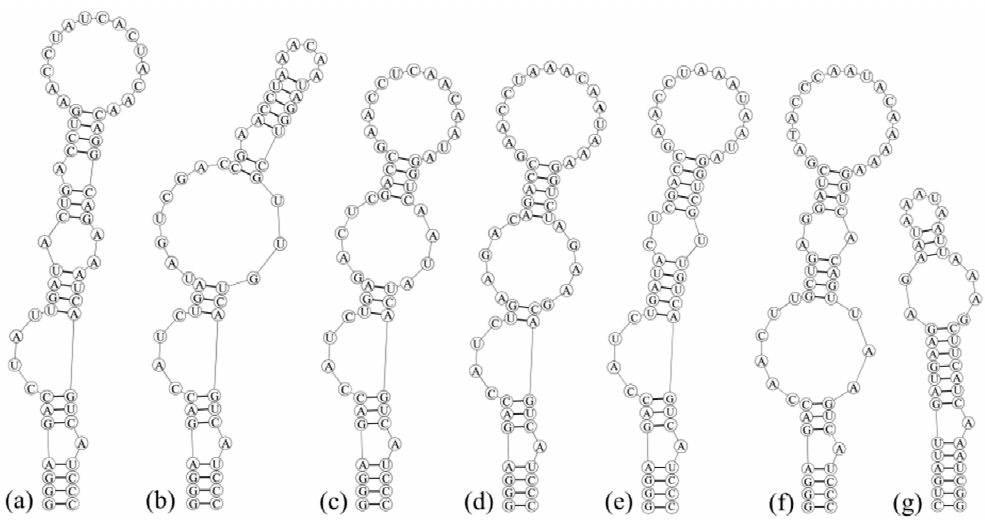
Figure 4. D1–D1 ′ helix in Microcoleusiopsis ganfuensis and other six related species. ( a ). Microcoleusiopsis ganfuensis CHAB 4138. ( b ). Microcoleus pseudautumnalis AK1609. ( c ). Microcoleus vaginatus CSU-U-KK1. ( d ). Microcoleus vaginatus PTRS-2. ( e ). Microcoleus autumnale SAG 78.79. ( f ) Oscillatoria princeps CCALA 1115. ( g ). Coleofasciculu chthonoplastes